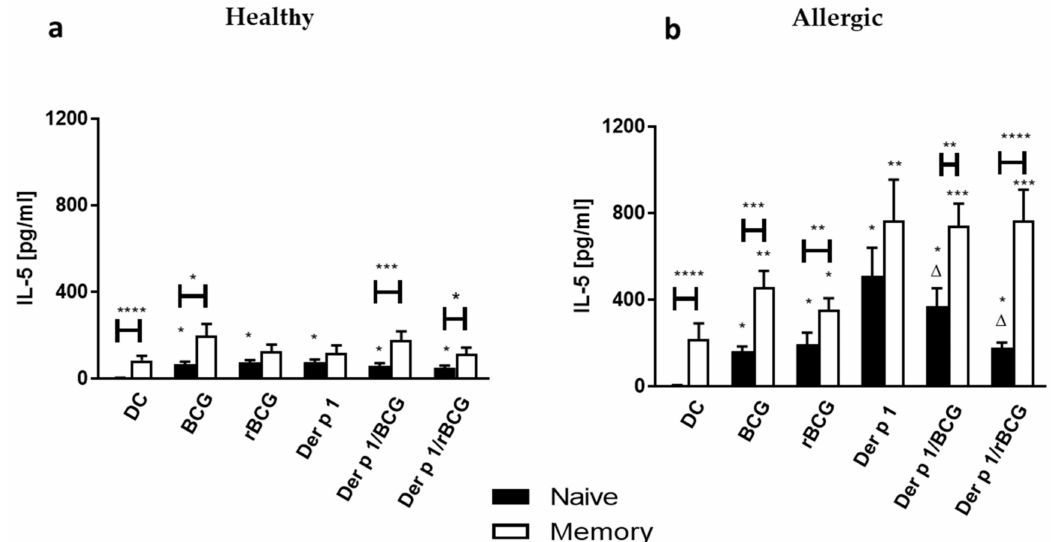
Figure 4. Secretion of IL-5 by human naive T cells ( a ) and memory T cells ( b ) following 96 h coculture with BCG- (1:1), rBCG-hIL-18 (rBCG)- (1:1), Der p 1- (1 µ g/mL), Der p 1/BCG- or Der p 1/rBCG-pulsed autologous MD-DCs (ratio MD- DCs/T cells, 1:10). The cytokine levels in the cocultures were measured in duplicate by ELISA. Data shown are the medians ± SEM for 22 allergic patients and 40 healthy donors. Statistical analyses were performed by using the Kruskal–Wallis test for unpaired data. * p < 0.05; ** p < 0.01; *** p < 0.001; **** p < 0.0001 versus control (unstimulated DC), unless indicated by the horizontal bars; ∆ p < 0.05 versus Der p